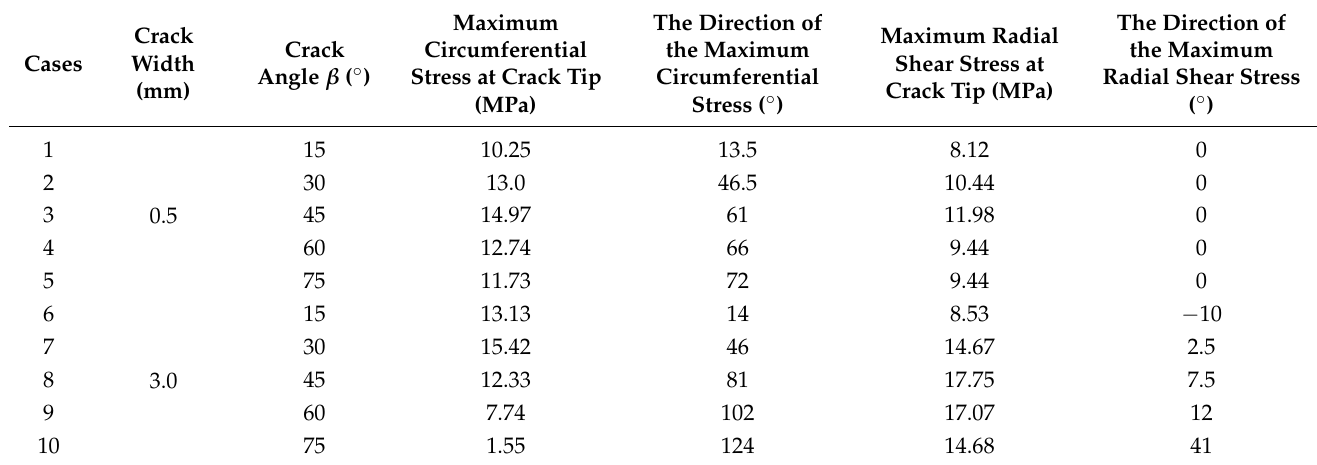
Table 5. Numerical results of stress near the crack tip.